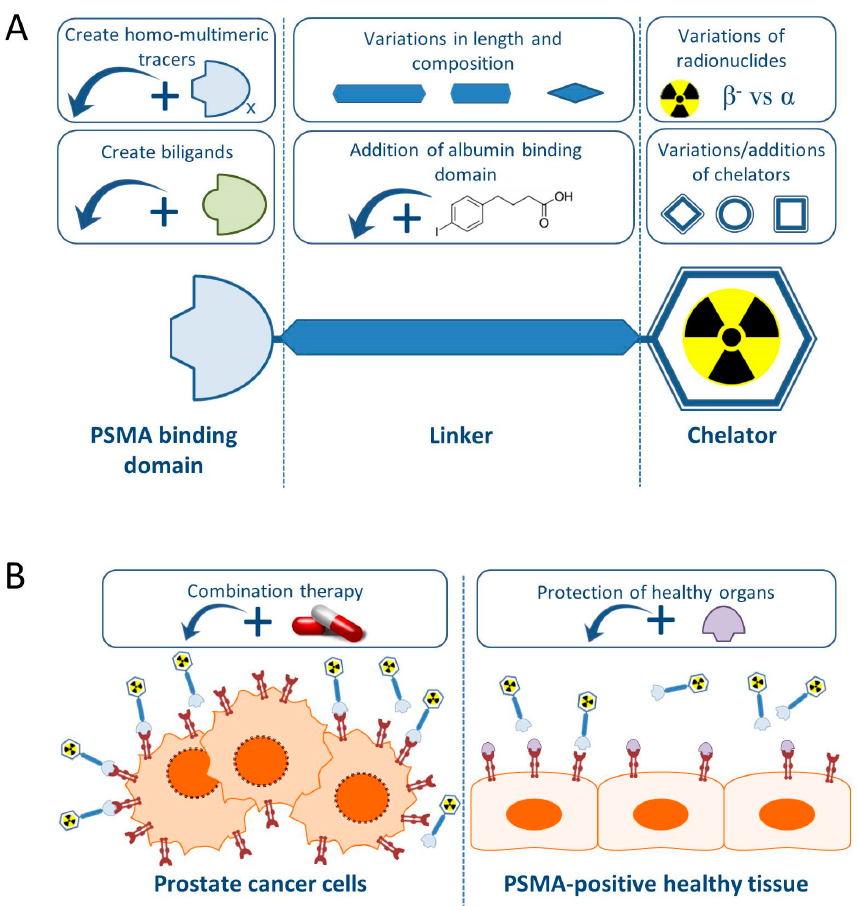
Figure 1. Schematic overview of preclinical research regarding the improvement of prostate specific membrane antigen-targeted radionuclide therapy (PSMA-TRT). ( A ) The basic building blocks of a PSMA-targeting small molecule inhibitor consist of a PSMA-binding domain, a linker and a chelator which can be labeled with various radionuclides. For each part of the tracer, additions or variations are being preclinically studied and described in this review. ( B ) Next to alterations to the targeting molecule, increasing the therapeutic impact on the tumor (left) is tried by combining PSMA-TRT with for instance androgen deprivation therapy. Protection of the healthy PSMA-expressing tissue (right) is studied by blocking the PSMA-molecule with for instance 2-PMPA.